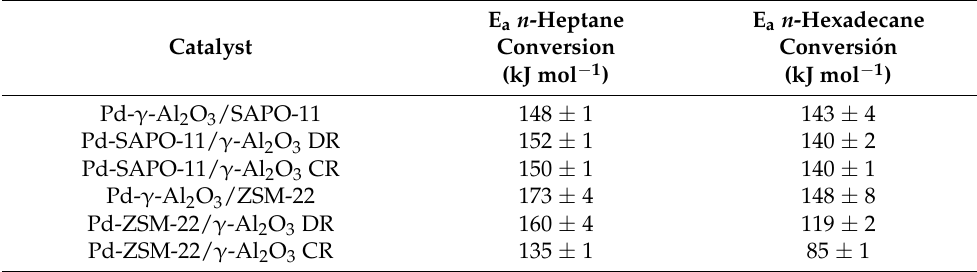
Table 2. Apparent activation energies (E a ) for the hydroconversion of n -heptane and n -hexadecane over each catalyst.